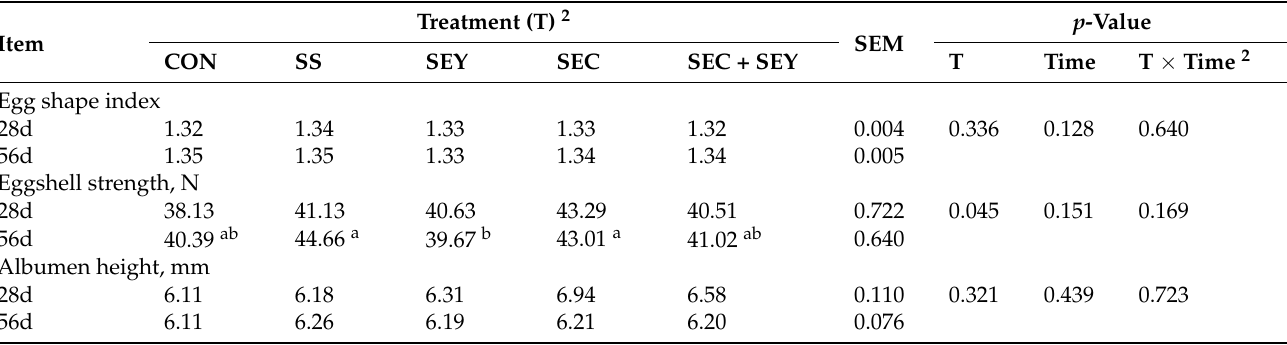
Table 4. Effects of different Se sources on egg quality 1